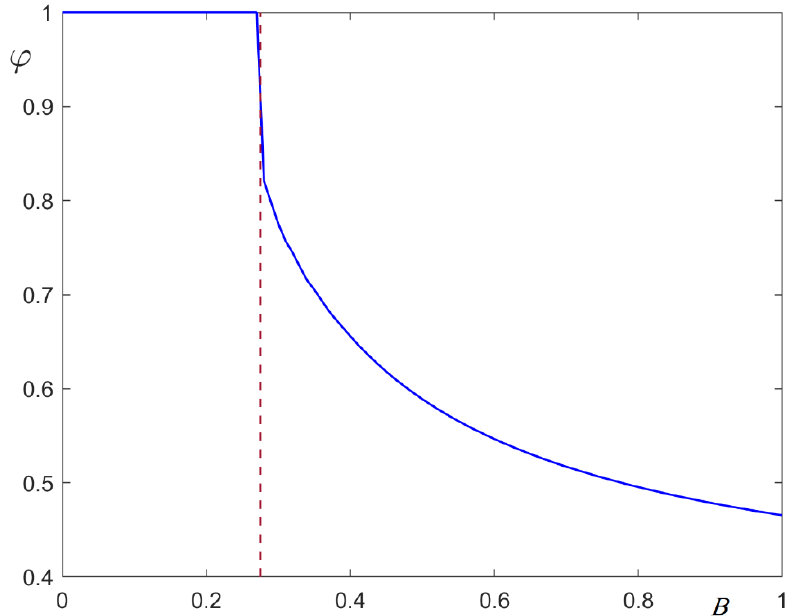
Figure 10. The plot for the dependence of the order parameter ϕ on the parameter B .